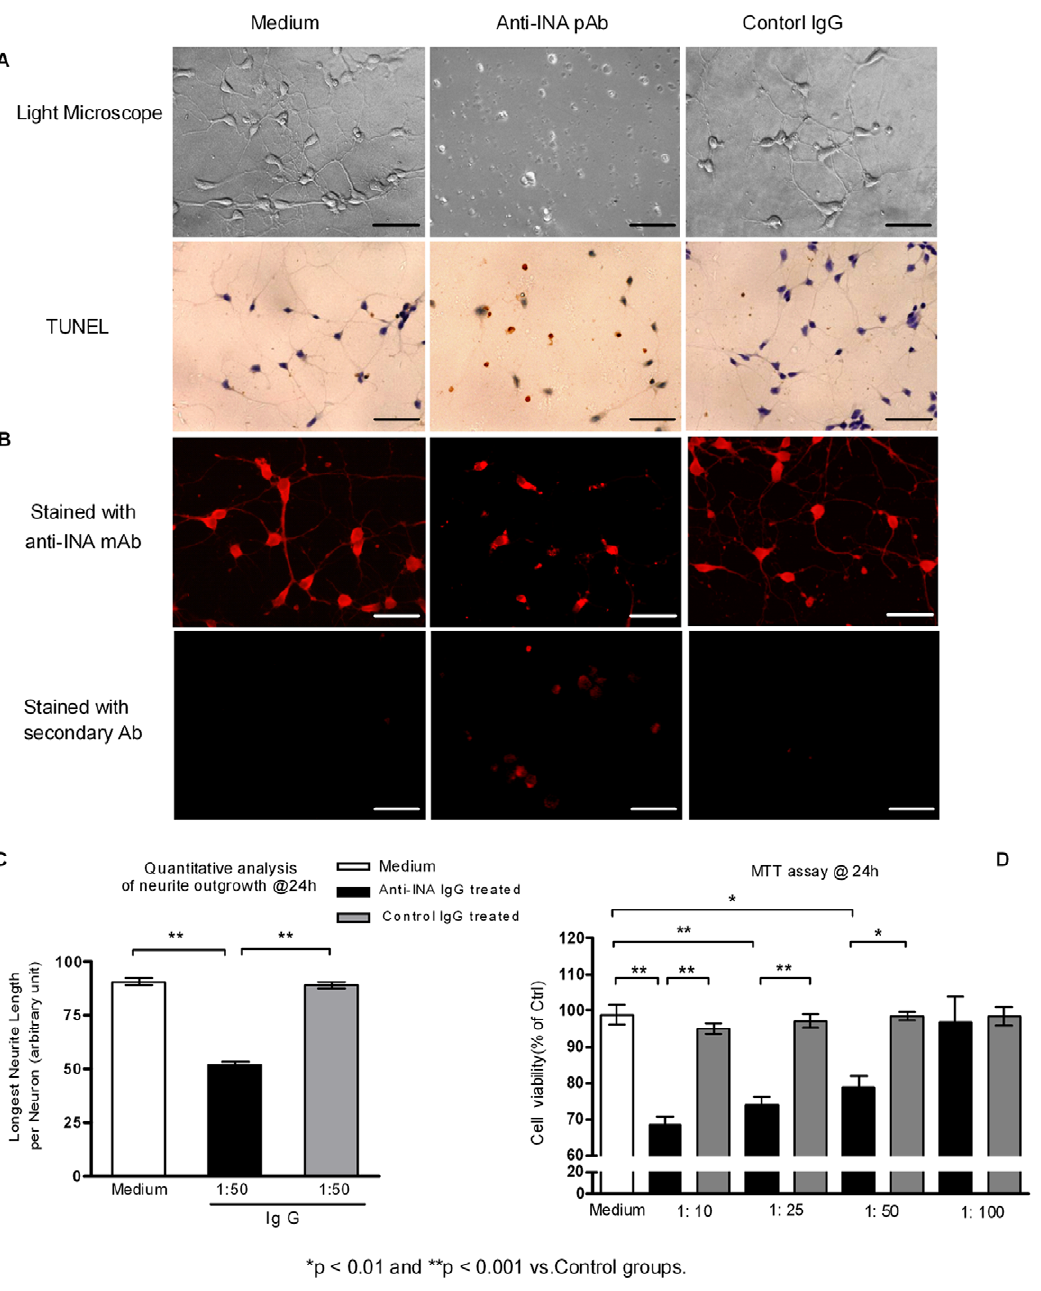
Figure 6. The anti-INA pAb inhibit the growth of neurites and result in neuron apoptosis in vitro. (A) Primary rat embryo neurons were co-cultured with medium, sterile anti-INA pAb (1:50), or control IgG for 96 hrs. The neurite outgrowth and cell viability was observed by light microscopy. Apoptotic cells were detected by TUNEL assay. (B) A monoclonal antibody (Mab 5224) against INA was used for displaying INA location. The TRITC goat anti-rabbit secondary antibody staining was to demonstrate the internalization of co-cultured Abs during the neuron cell growth. (Bar =25 m m) (C) Quantitative measurement of cultured neurons axonal length at 24 hrs. (D) Viability of primary cultured neurons subject to indicated concentrations of anti-INA pAb or control IgG after 24 h. The percentage of cell survival normalized to control cells was applied in MTT assay. Data are represented as mean 6 SEM of three independent experiments.